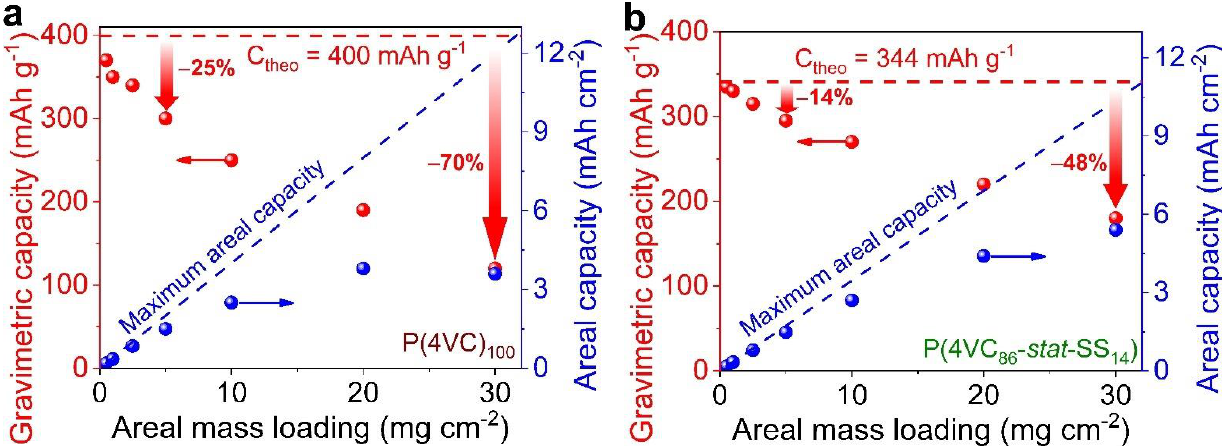
Figure 5. Comparative electrochemical performance of Zn||P(4VC) 100 and Zn||P(4VC 86 - stat -SS 14 ) cells at different mass loadings. ( a , b ) Gravimetric/areal capacities of P(4VC) 100 ( a ) and P(4VC 86 - stat -SS 14 ) ( b ) as a function of mass loading.